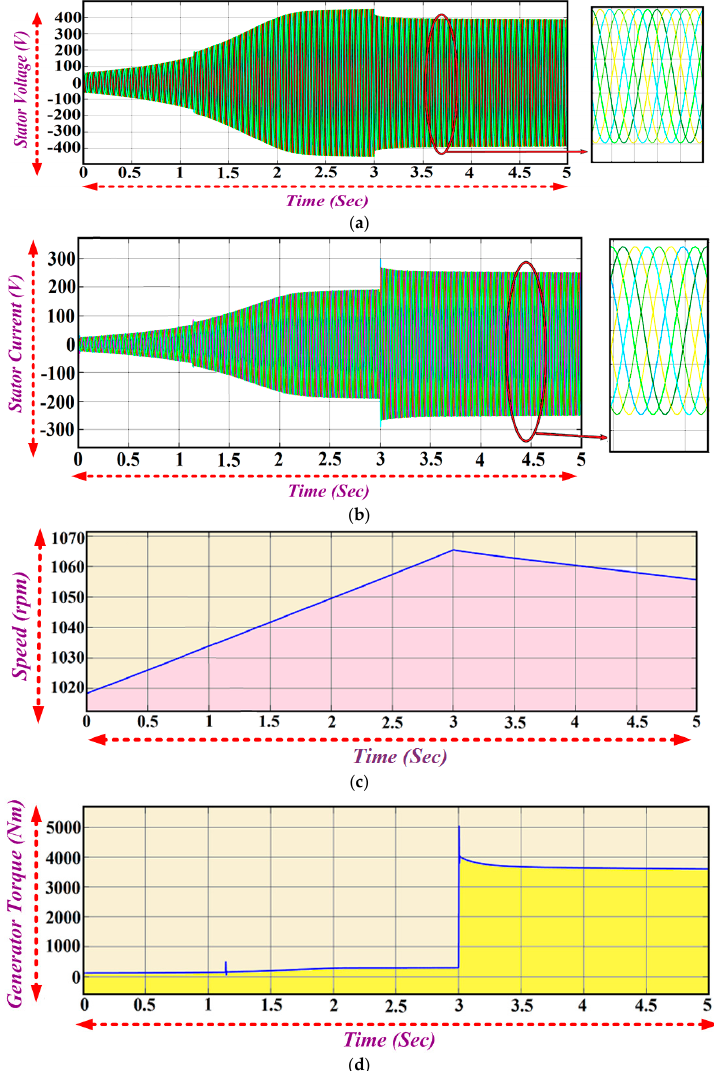
Figure 7. 7 P IG ( a ) Output Voltage; ( b ) Current; ( c ) Generator speed; ( d ) Generator Torque. Figure 7. 7PIG ( a ) Output Voltage; ( b ) Current; ( c ) Generator speed; ( d ) Generator